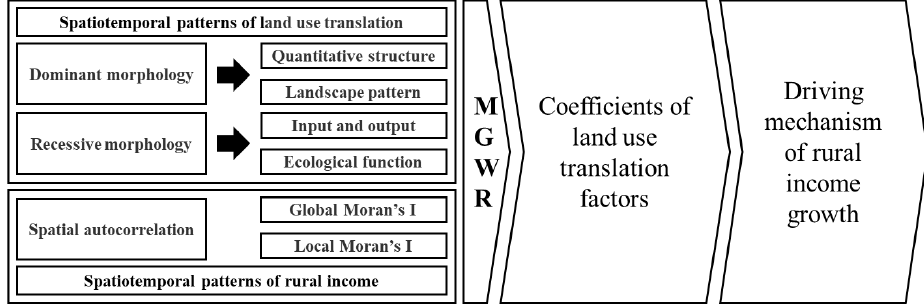
Figure 2. Research